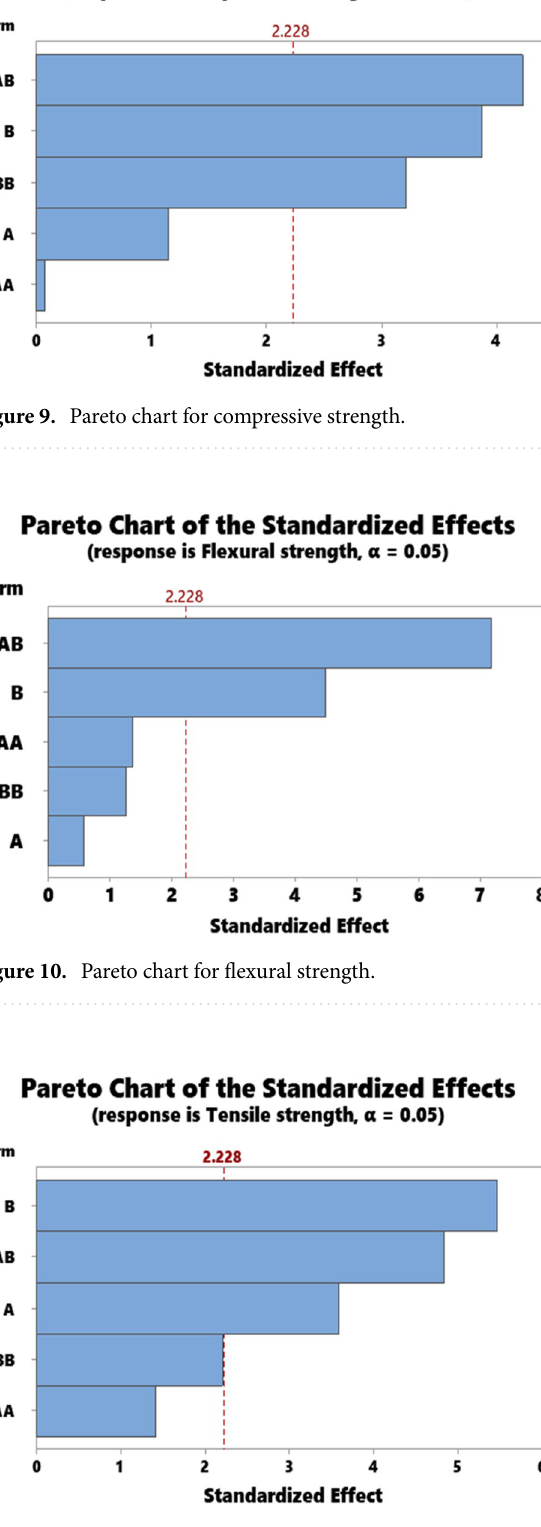
Figure 11. Pareto chart for tensile